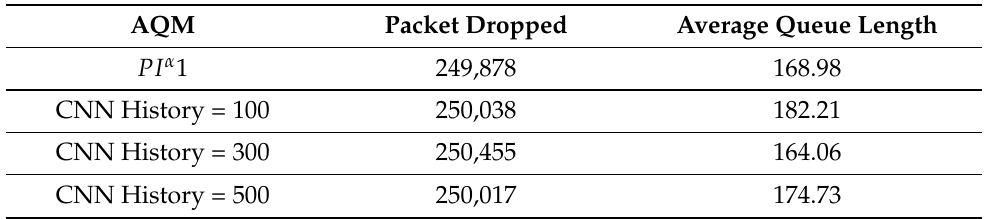
Table 8. Detailed results of queue occupancy obtained for CNN model with the last layer activation function Softmax, trained using data regarding PI α 1 controller and parameters: K P = 0.0001, K I = 0.0004, α = − 0.4 and H = 0.5.